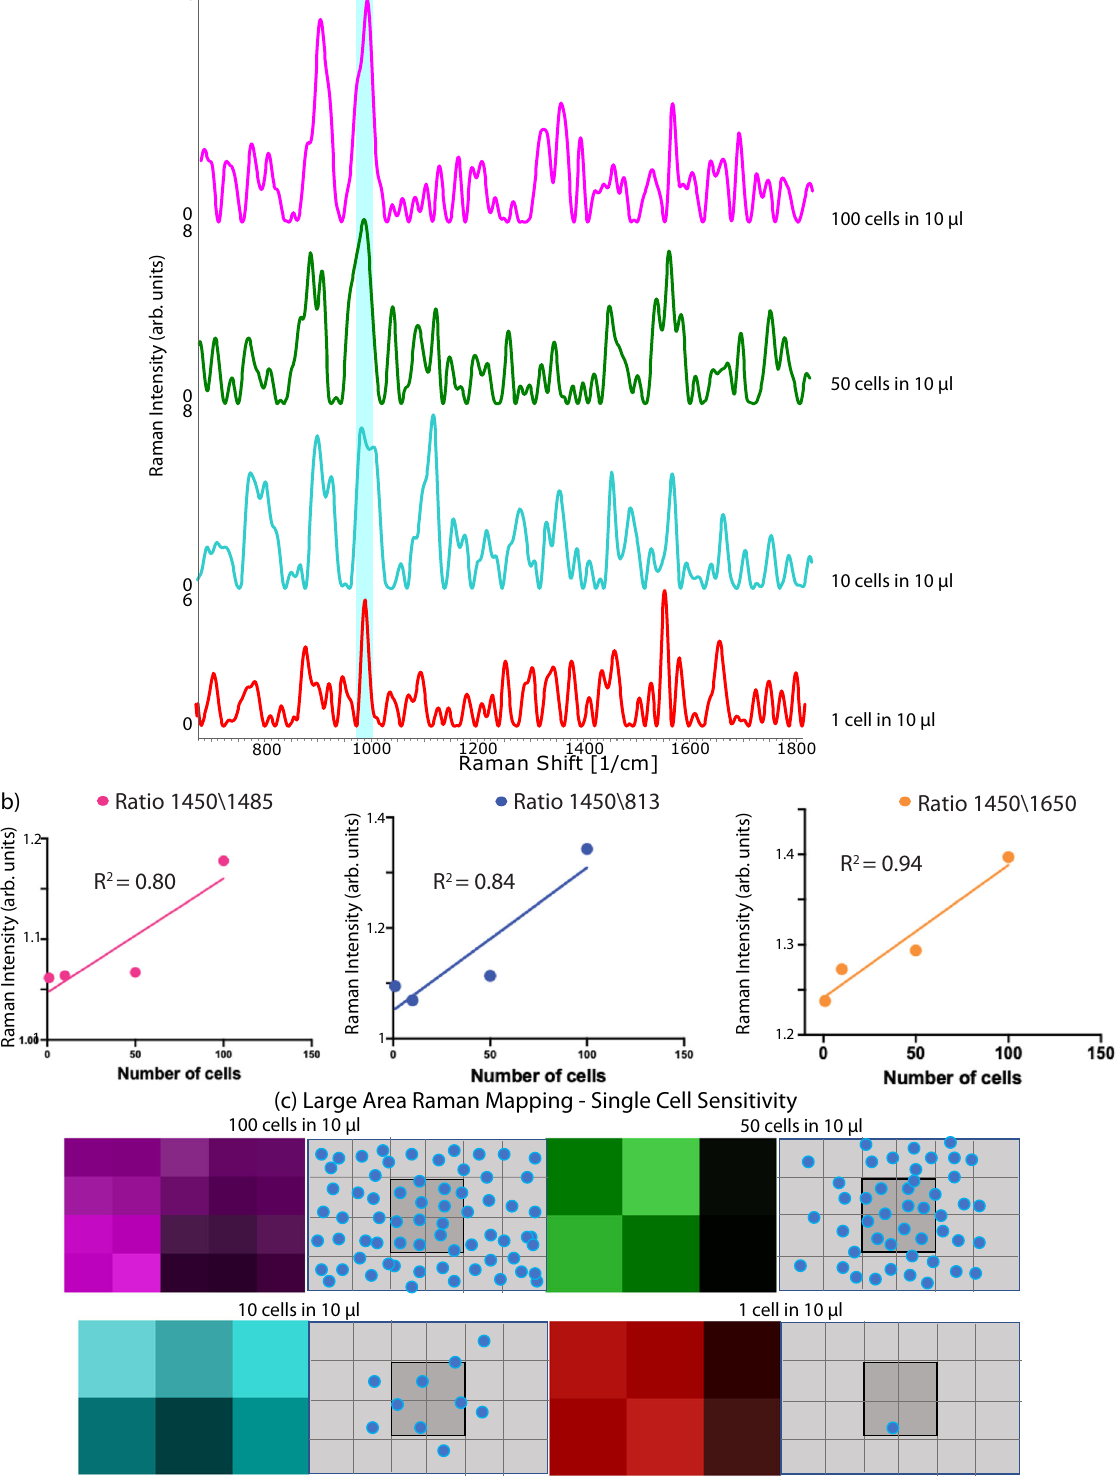
Fig. 5 | Single-cell sensitivity of OncoImmune probe platform. a Raman spectra of cells at 100 cells per µ l (purple), 50 cells per µ l (green), 10 cells per µ l (cyan) to 1 cell per µ l (red) cell density. Source data are provided as Source Data File. b Ratio analysis at I1450/I1650 (lipid/protein) — pink line, I1450/I813 (lipid/RNA) — blue line and I1450/I1485 (lipid/DNA) — orange line demonstrated increasing trend with increasingconcentration(R20.94,0.84,0.80respectively). c Largeareamapping —